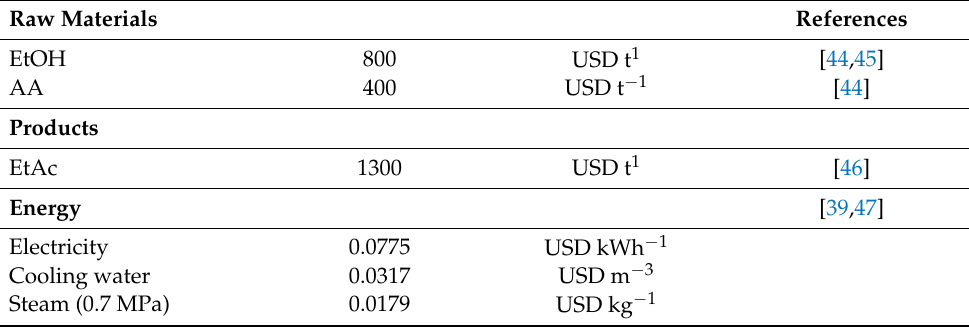
Table 5. Prices of raw materials, products, and energy used in economic